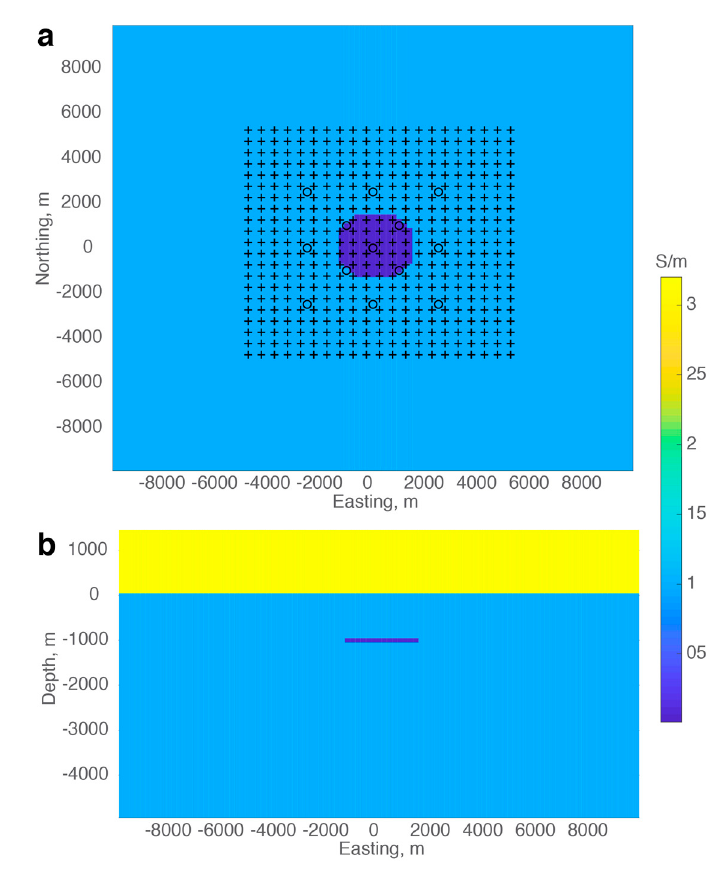
Figure 1. Model conductivity and transmitter/receiver layout exemplified by a 1500 m radius target structure. ( a ) Plan view at target depth showing locations of transmitters (o) and receivers (+) projected from the seafloor. ( b ) Section view showing target structure at a depth of 1000 m below seafloor. The entire model computation domain is shown.